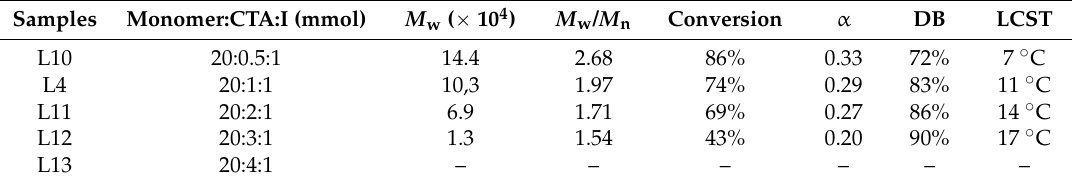
Table 4. Effect of CTA’s concentration on polymerization.